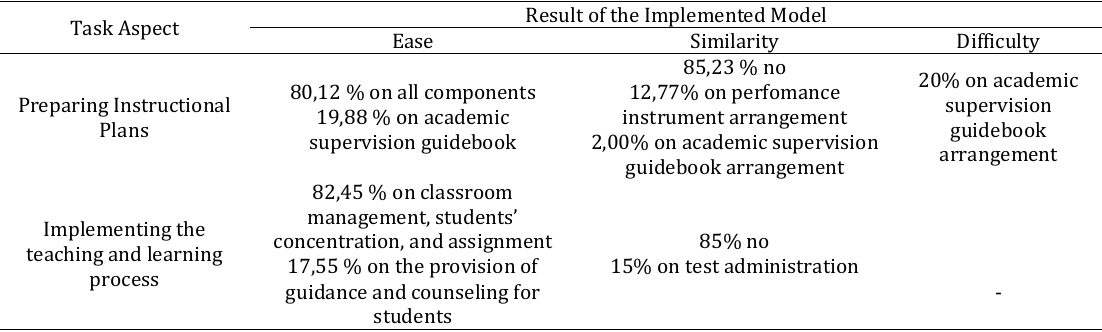
Table 1 The Effect of the Implementation of Academic Supervision Model Using Academic Supervision Guidebook on